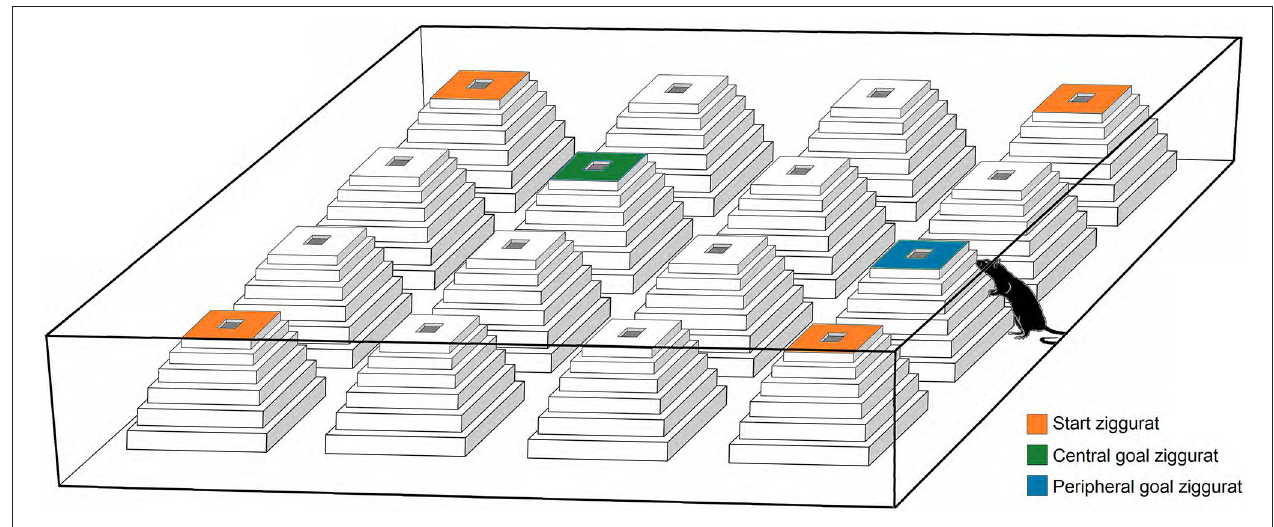
the ZT used in the present study requires animals to use spatial (distal and/or proximal) cues to navigate to the goal ziggurat. On testing days, the rats are released from each starting point (orange ziggurats) and explore the environment in which only one goal ziggurat (peripheral or central; blue and green ziggurats, respectively) is baited (Faraji et al.,